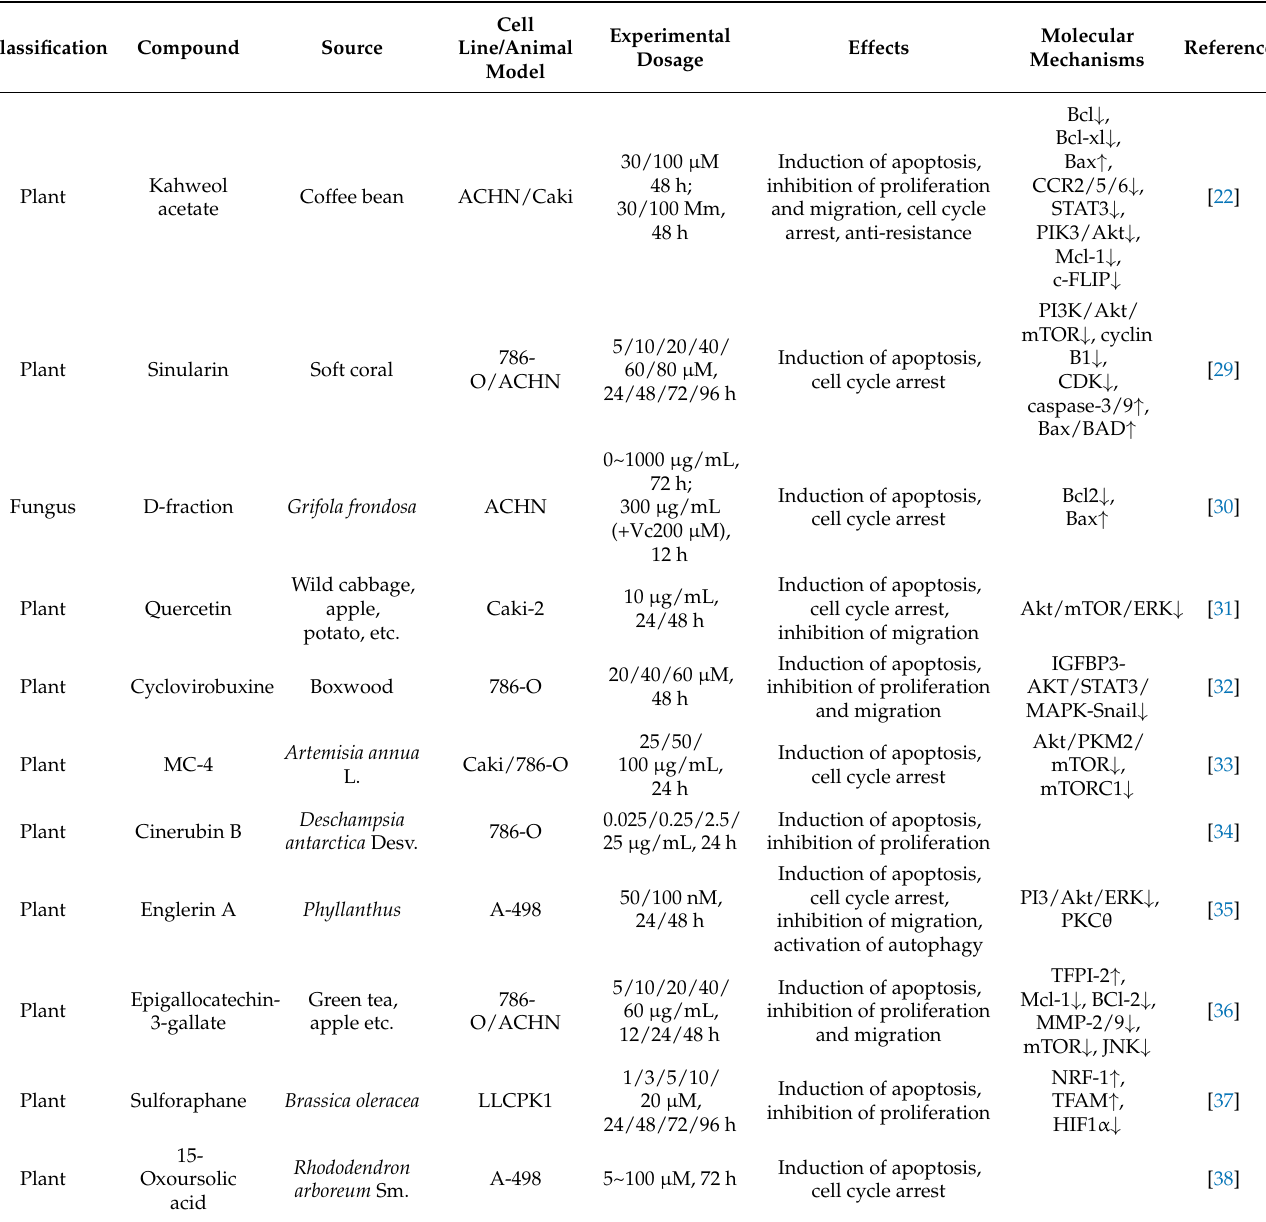
Table 1. Single compounds from natural products showing cancer-intrinsic inhibition (major in apoptosis induction and/or proliferation inhibition) in renal cell